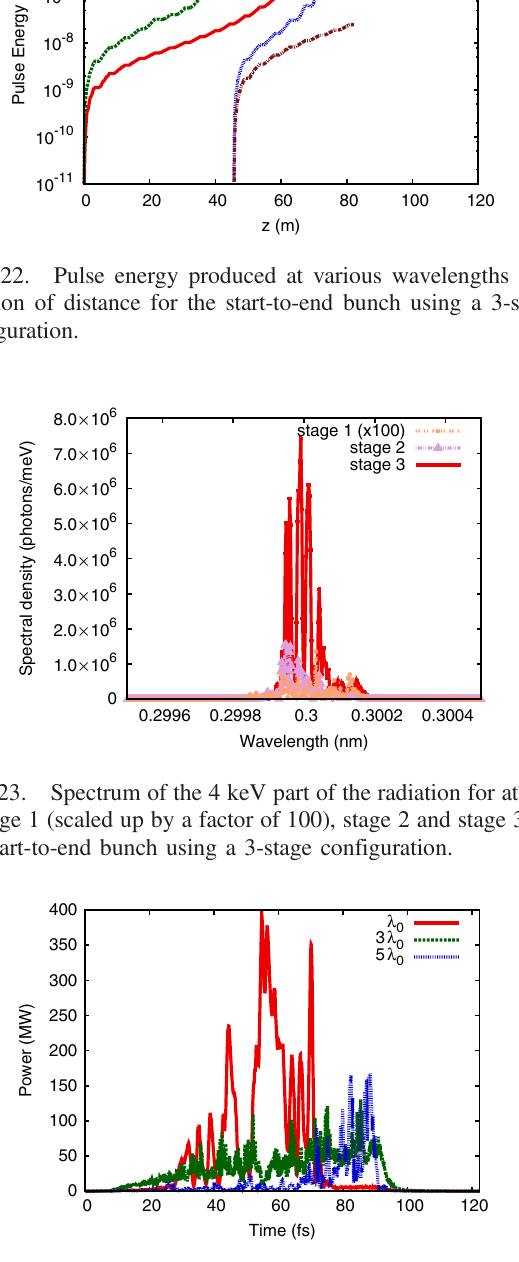
FIG. 24. Profile of the final output power produced at wave- lengths of 0.3 nm, 0.9 nm, and 1.5 nm for a start-to-end bunch using a 3-stage